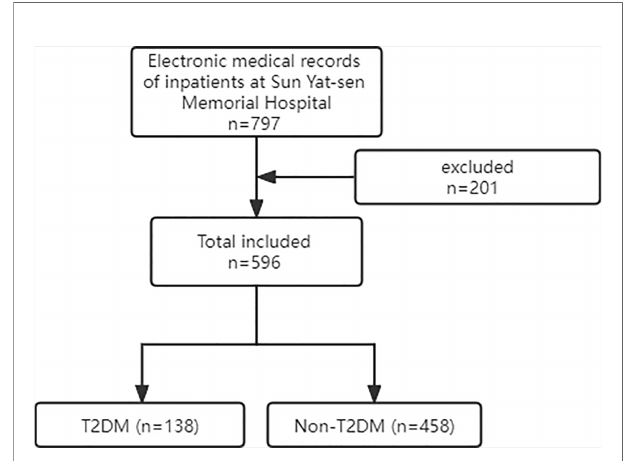
FIGURE 1 | Article Flow